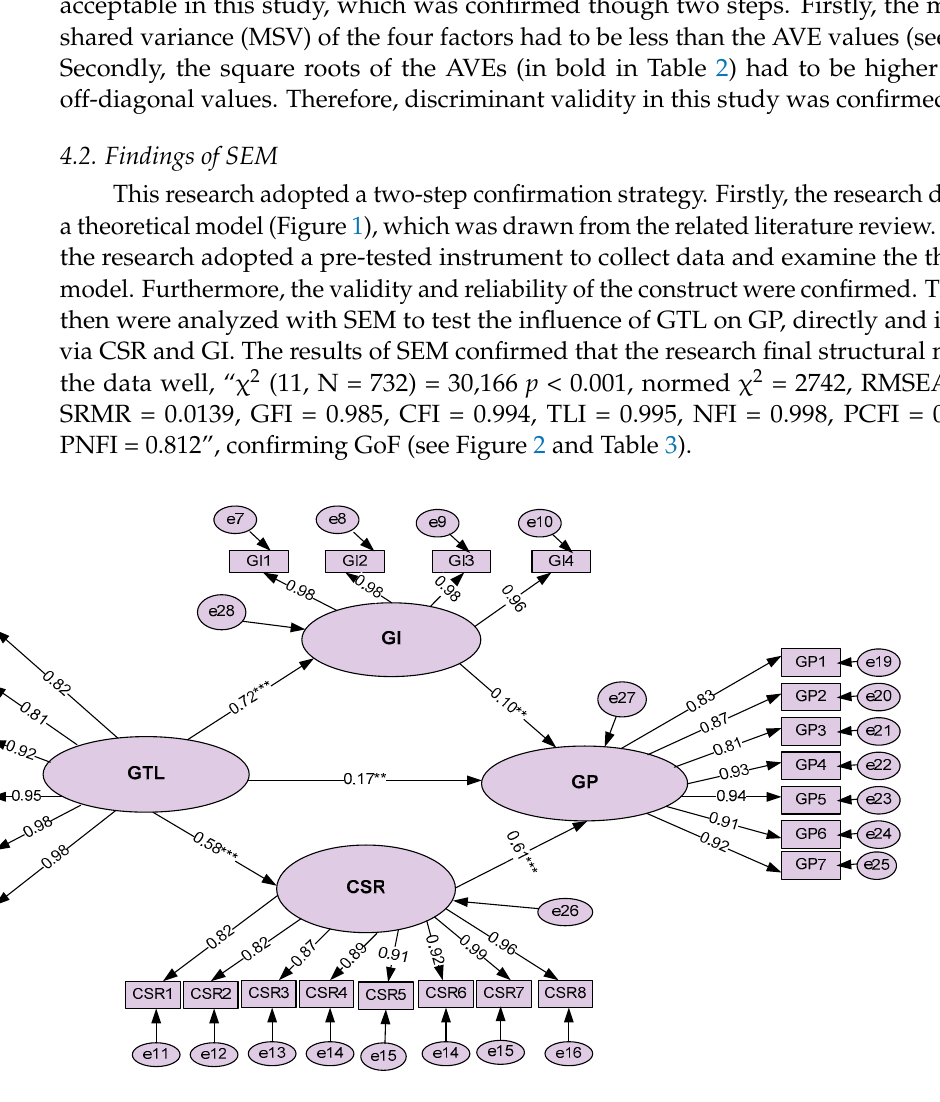
Figure 2. The final research structural model (developed by the authors using SPSS and AMOS software). *** p < 0.001; ** p <